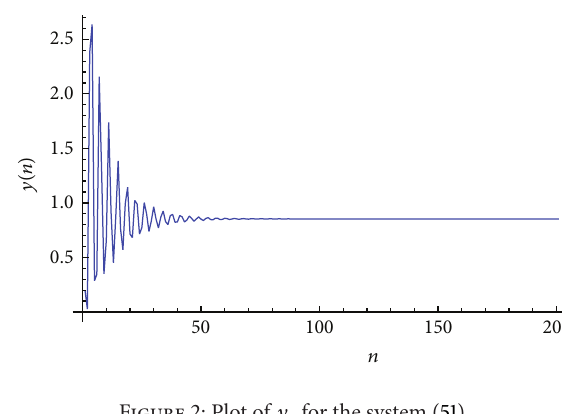
Figure 2: Plot of 𝑦 𝑛 for the system (51).